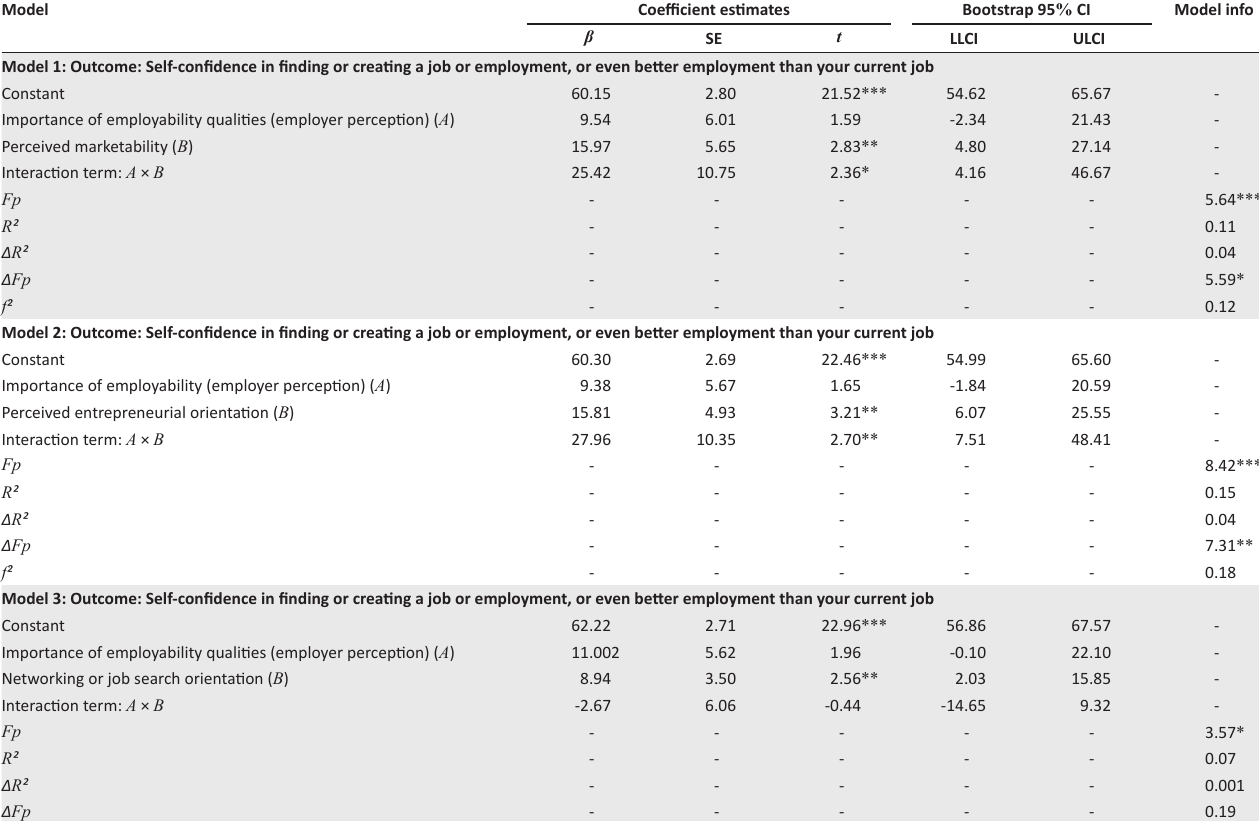
TABLE 3: Moderated regression results: Interaction effects between employer’s importance of employability qualities, and marketability, entrepreneurial orientation and networking or job search orientation as predictors of self-confidence in finding or creating a job or employment ( N = 153).